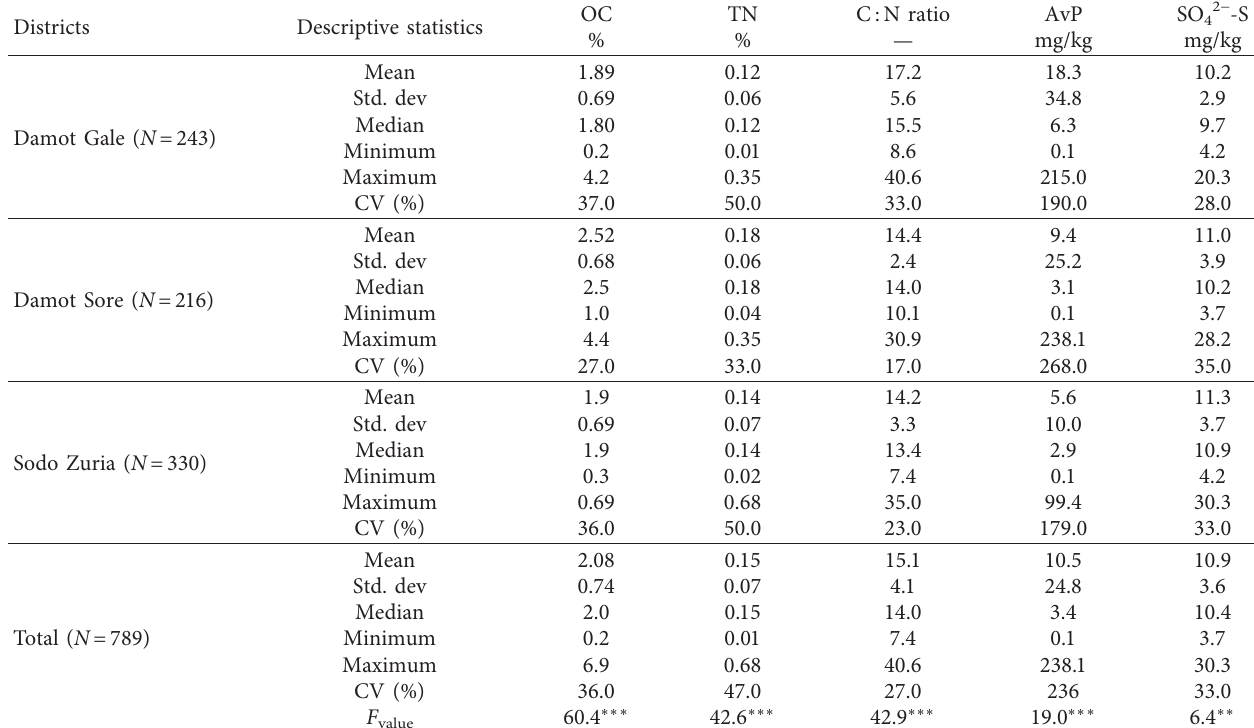
Table 5: Descriptive statistics of soil OC, TN, AvP, and SO 42 − -S for surface soil. Districts